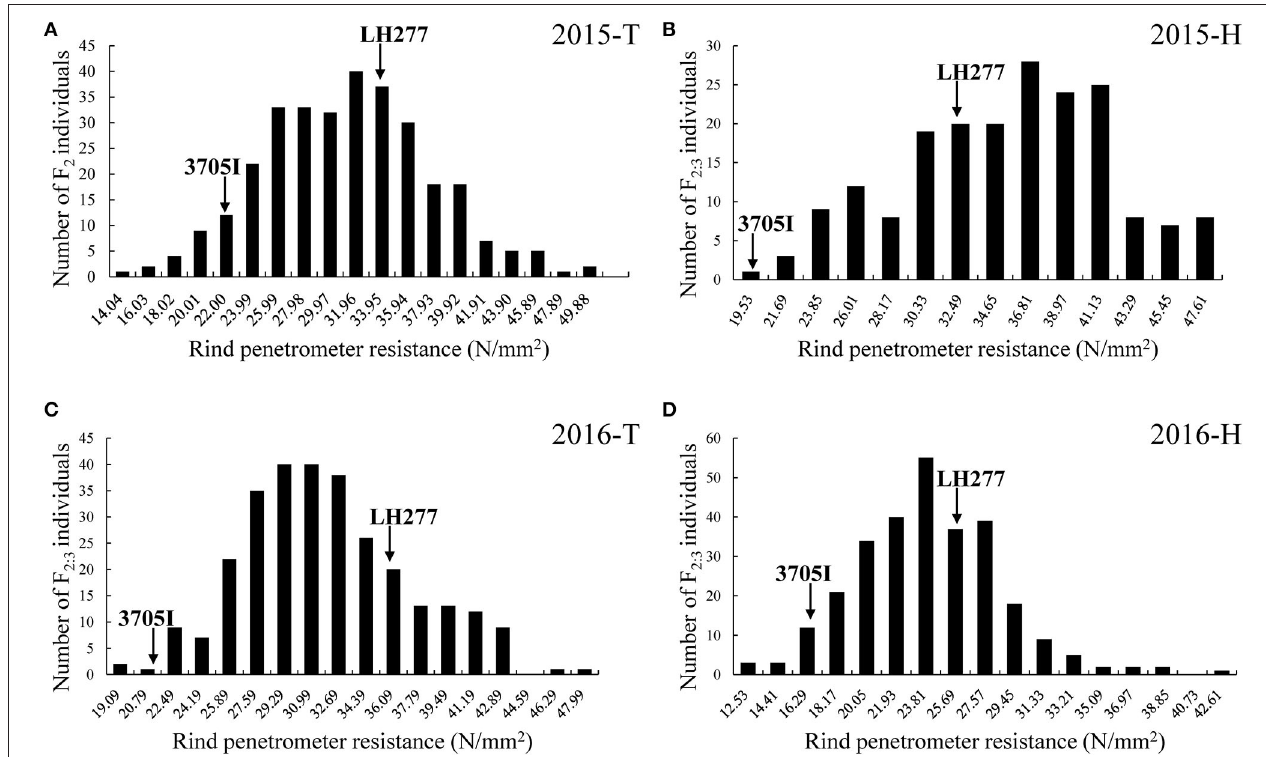
FIGURE 3 | Frequency distribution of rind penetrometer resistance in the F 2 and F 2 : 3 populations, respectively. (A) RPR of F 2 in 2015-T. (B) RPR of F 2 in 2015-H. (C) RPR of F 2 : 3 in 2016-T. (D) RPR of F 2 : 3 in 2016-H. The x-axis indicates the rind penetrometer resistance, and the y-axis indicates the number of individuals in each group. In each trial, the two arrows represent the rind penetrometer resistance of both parental lines. T, Tai’an; H, Hainan.